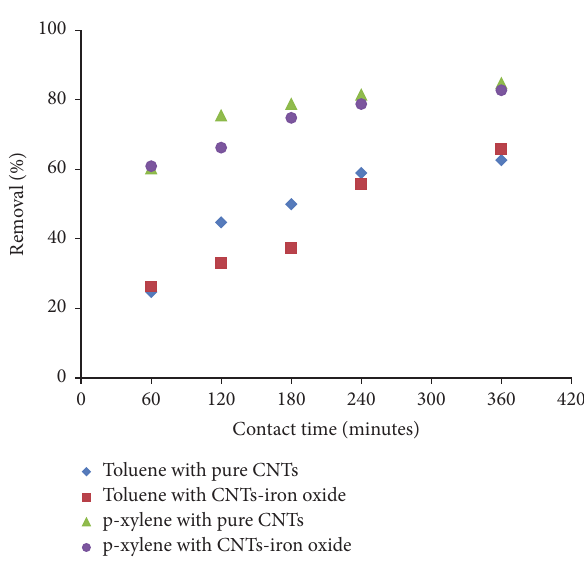
Figure 7: Effect of contact time on the removal of toluene and p- xylene (initial concentration: 61mg/L for toluene and 48 mg/L for p-xylene, adsorbent dosage: 50 mg, shaking speed: 200 rpm, pH: 6, and temperature: 298 K).